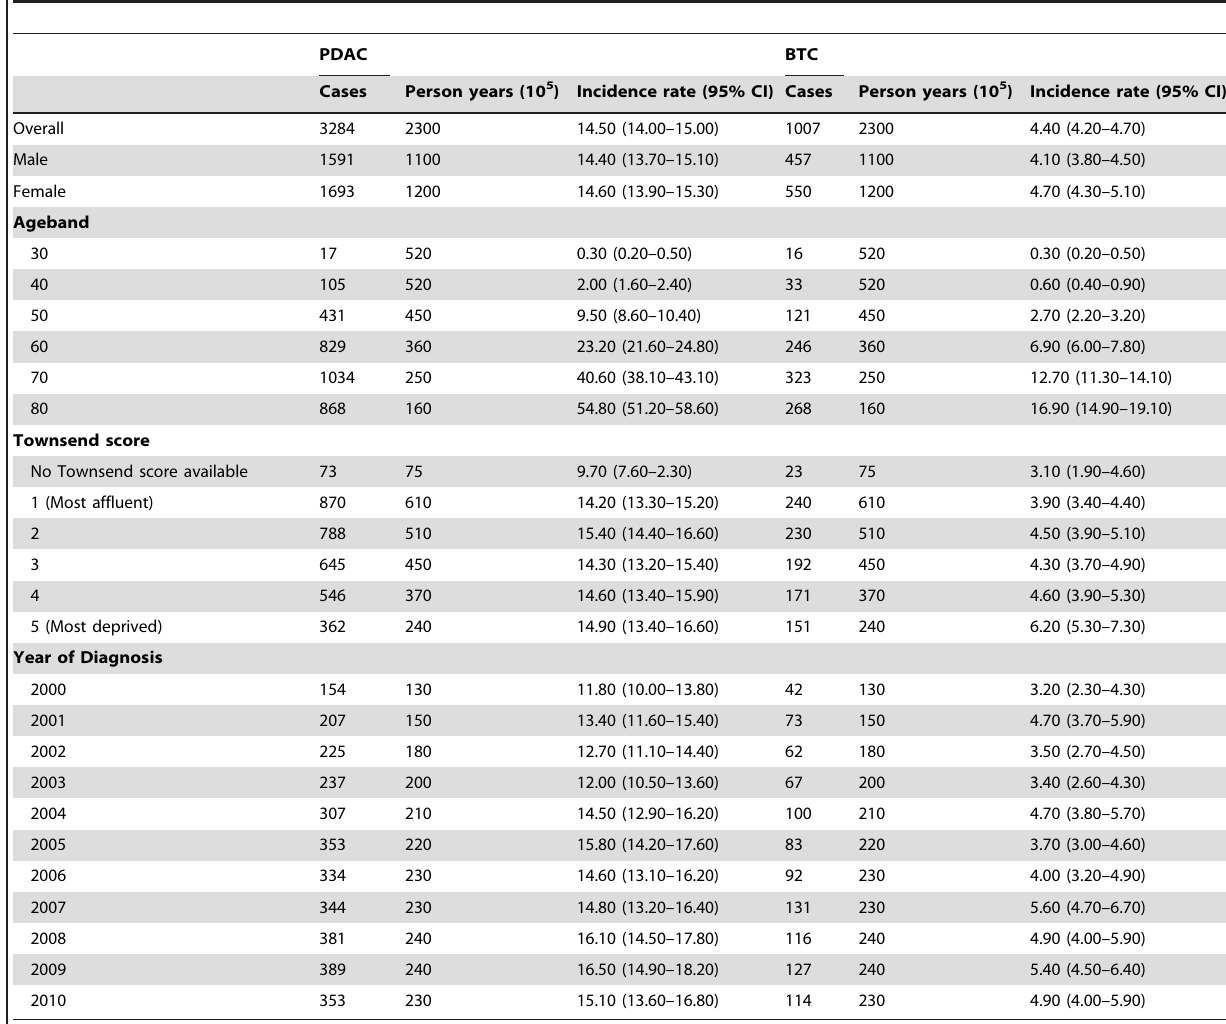
Table 1. Incidence rates of PDAC and BTC per 100,000 population, between 2000 and 2010 in primary care across a range of sociodemographic